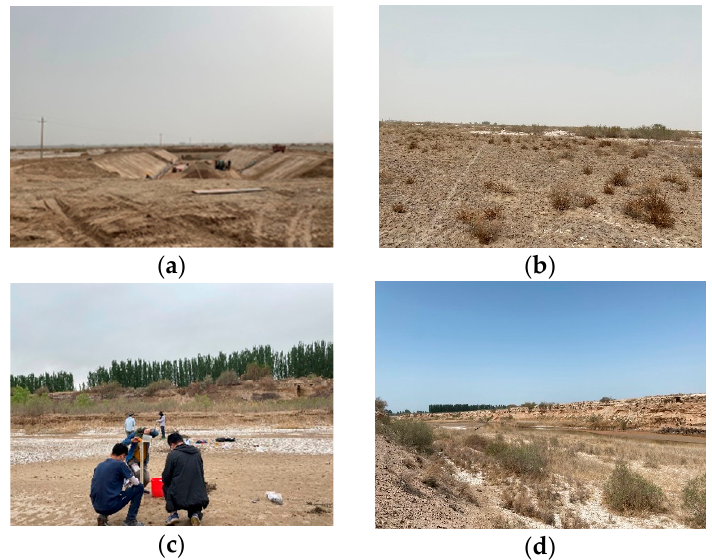
Figure 1. Salinization landscape in the study area: reclamation of saline alkali land ( a ); oasis edge salinization ( b ); TDS of river water increases ( c ); salinization in the lower reaches of the river ( d ).